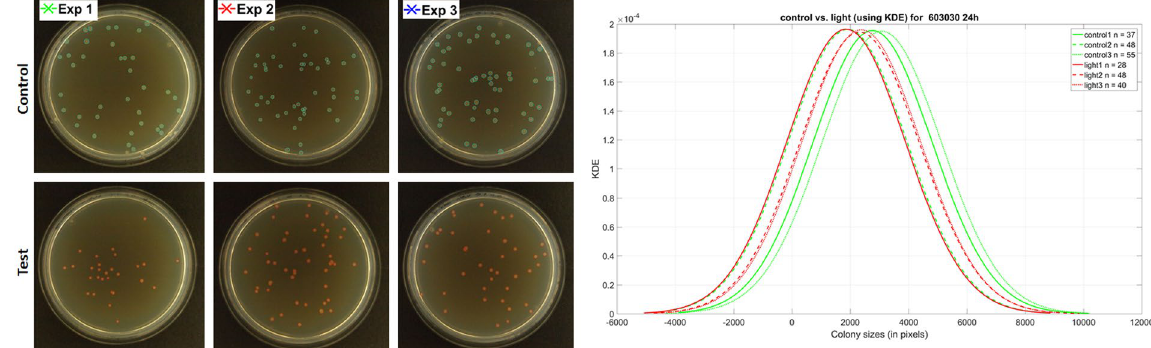
Figure 3. Analysis of control/test images: First and second row on left show the segmentation results for control (light blue) and test (red) images respectively. On the right side, Kernel Density Estimation (KDE) plot is displayed on y-axis for colony sizes in pixels (x-axis). The bandwidth ( bw = 2000) here determines the smoothness in the curves. Green lines in plot represent control experiment results, where as red lines represent test experiment (light irradiation in our case) results. The number of colonies found in each image is denoted by n using red/green color based on the experiment type (light/control).